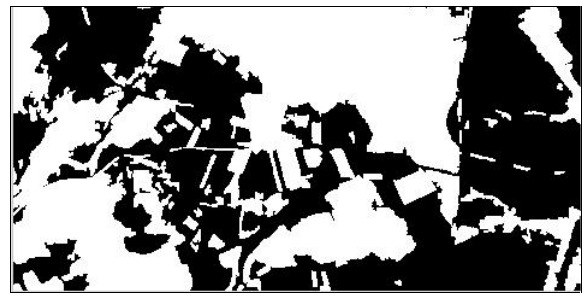
Figure 7. Example of dilated and fill holes image.